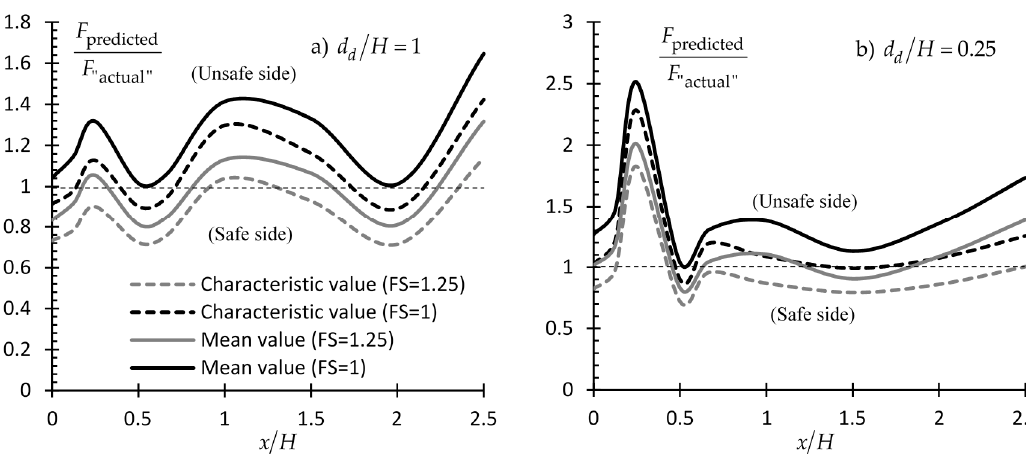
Figure 23. F predicted / F ”actual” vs. x / H curves using both mean and characteristic values (solid and dashed lines respectively) for FS = 1 and 1.25. Figure referring to the case of a sliding wall and to two sampling domain cases ( d d / H = 1 ( a ) and d d / H = 0.25 ( b )). The reference wall was used. Soil characteristics are shown in Table 1 (Example #3). Additionally, for this example, γ Μ = φ γ = 1.